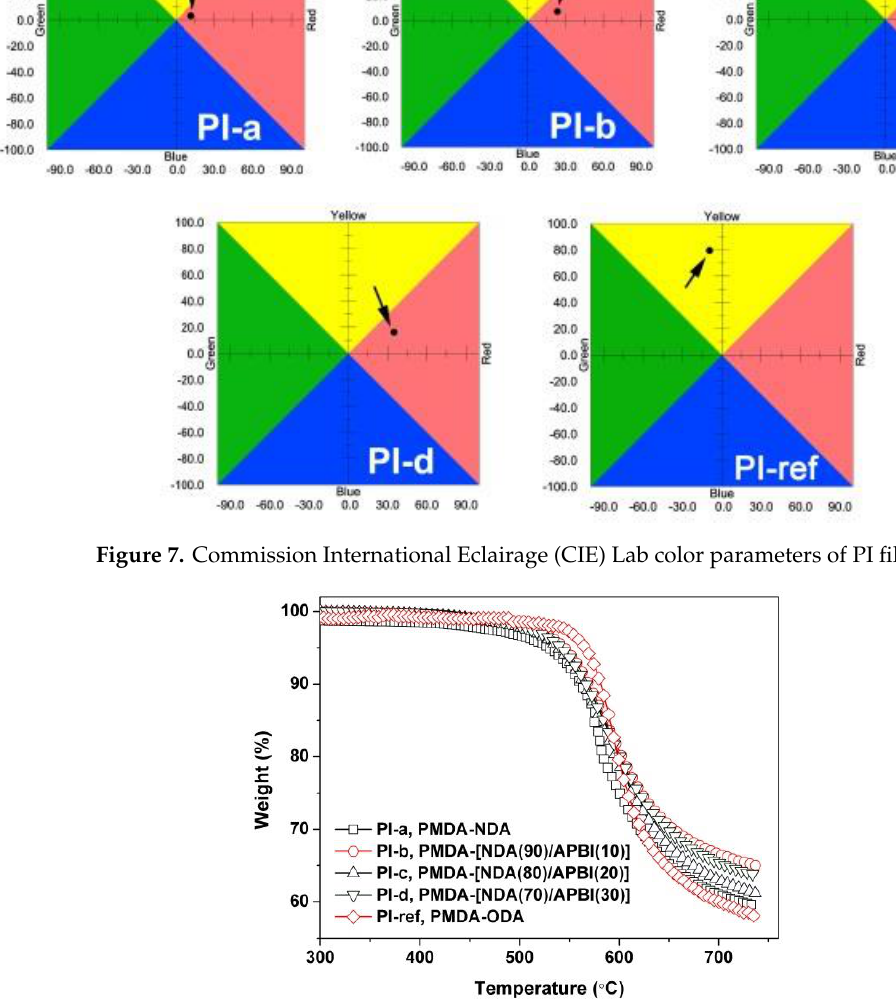
Figure 8. Thermogravimetric analysis (TGA) plots of black PI and PI-ref films in nitrogen.